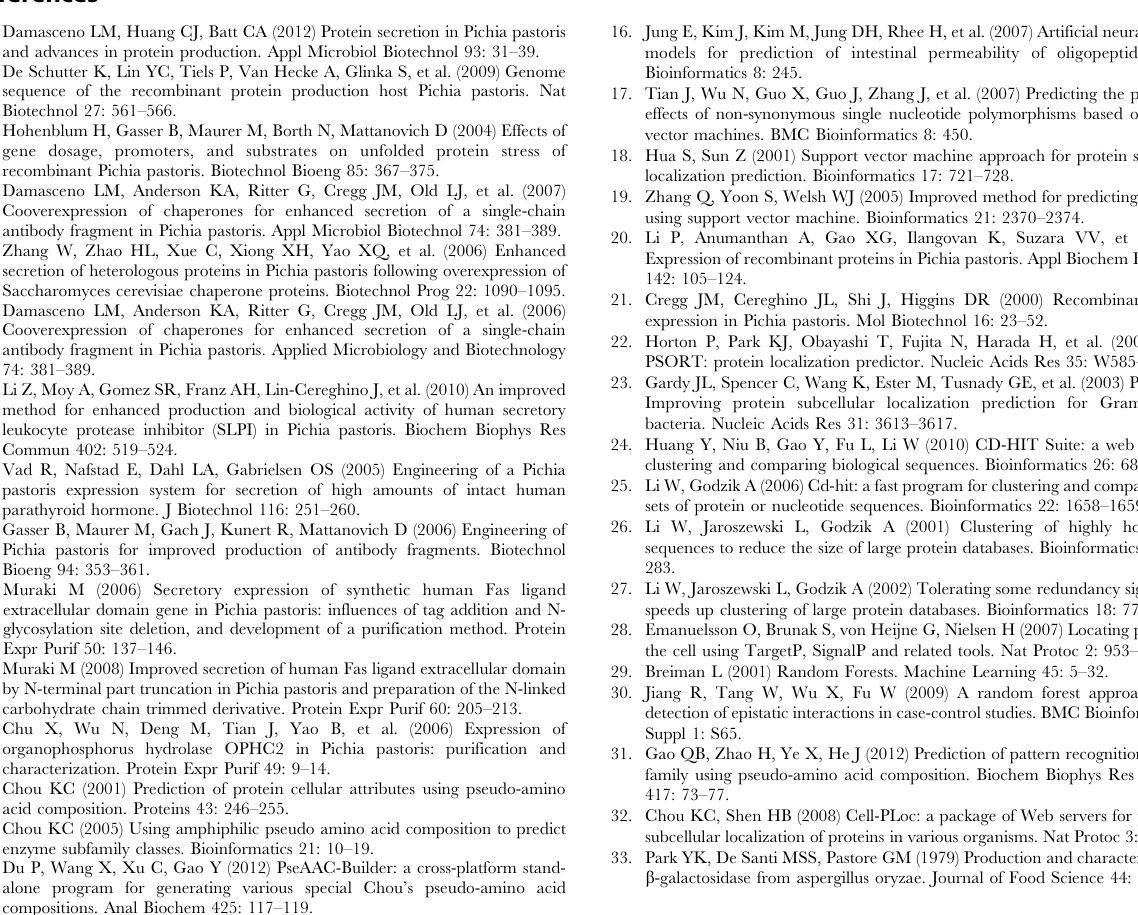
Figure S1 ROC curves of random prediction and Presep prediction with two different parameters. The parameter 1 means that w is 0.05, l is 19 and the type I coding scheme. The parameter 2 means that w is 0.05, l is 20 and the type II coding scheme. The ROC curves were obtained using Random forests with the 20-fold cross validation test on the Secreprot dataset. Figure S2 Schematic diagram of the recombinant constructs. Table S1 Predicted propensity and the experimental results on the six b -galactosidases. Table S2 The hydrophobicity, hydrophilicity,